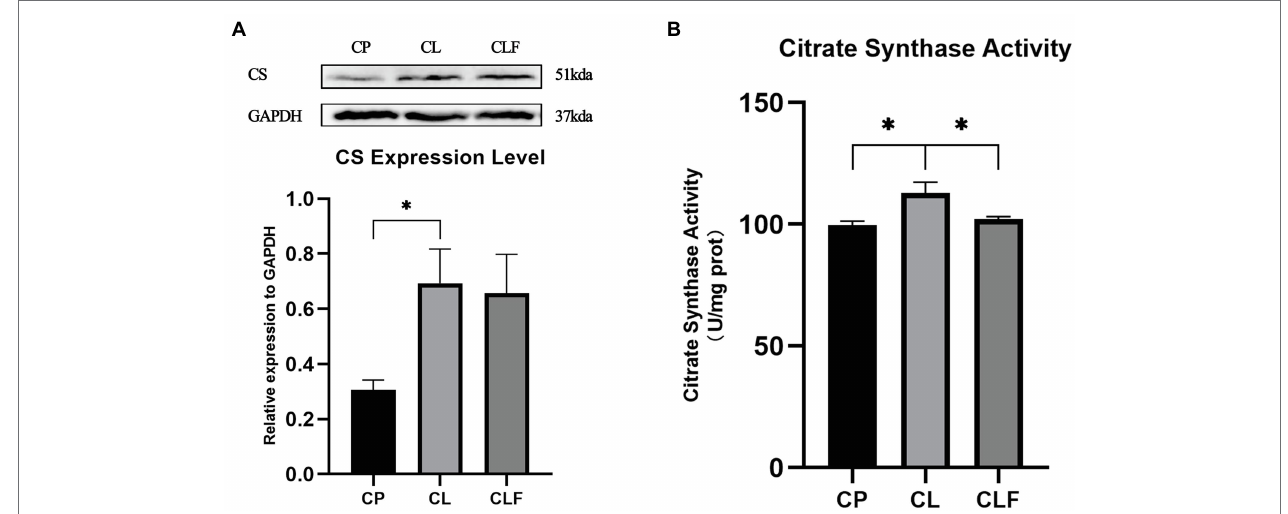
FIGURE 8 | The activity and expression level of citrate synthase (CS). (A) The expression level of CS in gastrocnemius after chronic administration ( n = 8). (B) The activity of CS after chronic administration. CP, chronic PBS treated group; CL, chronic lactate treated group; and CF , chronic forskolin treated group. Relative expression levels were normalized to GAPDH. Three bands are used for statistics. The data are presented as the mean ± SD, and significant differences among the groups were analyzed with one-way ANOVA. * p <